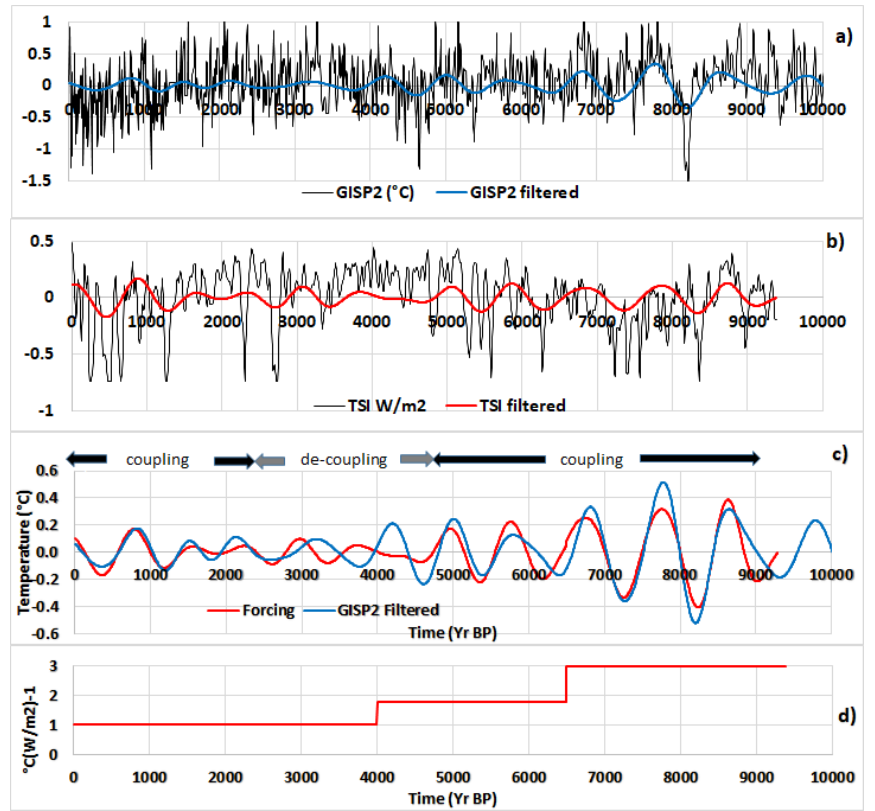
Figure 8. Impact of the forcing on the global temperature into the band 576 – 1152 years ( a ) the global temperature (GISP2); ( b ) the Total Solar Irradiance (TSI); ( c ) Comparison of the TSI multiplied by the forcing efficiency in ( d ) and the global temperature. A delay of 50 years is applied to forcing.